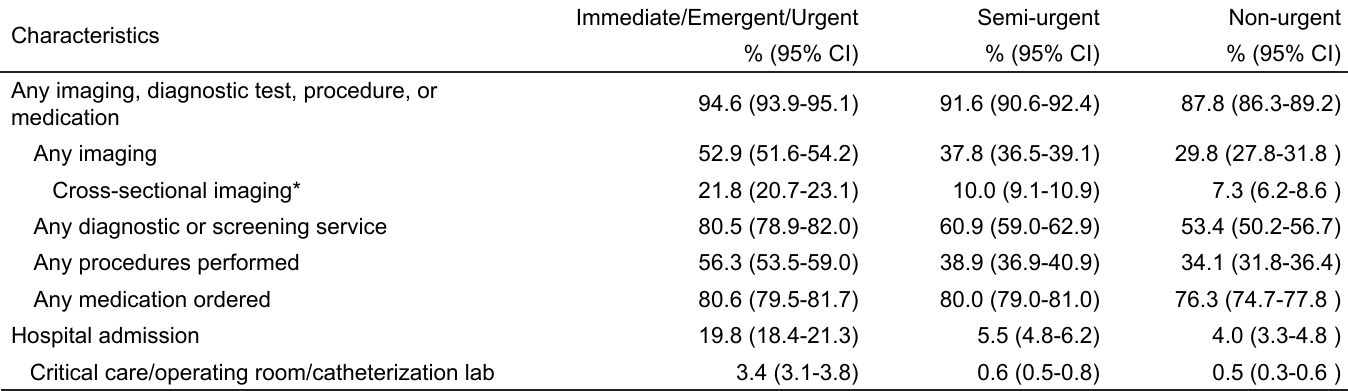
Table 2. Resource utilization of 2006-2009 United States emergency department visits by triage acuity